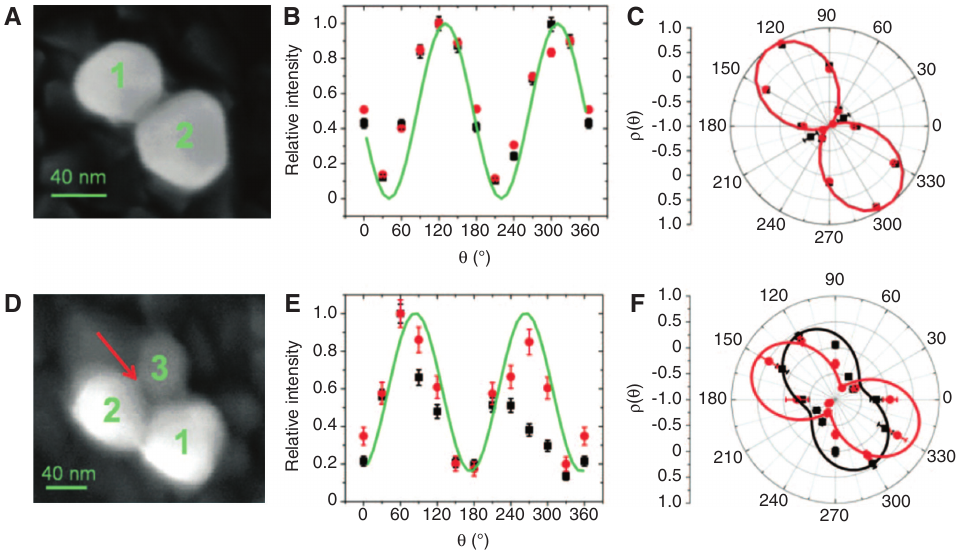
Figure 5: Polarization responses of NP dimer and trimer [53]. (A) A SEM image shows a dimer of Ag NPs, which is tilted about 40 ° from the vertical direction. (B) Normalized Raman scattering intensity at 555 nm (black squares) and 583 nm (red circles) as a function of the rotation angle of the incident polarization. The green line is the result of generalized Mie theory calculation of the normalized local field enhance- ment factor at 532 nm excitation. (C) Depolarization ratio measured at 555 nm (black squares) and 583 nm (red circles). Black and red lines show the results of Mie theory calculations performed at 555 and 583 nm, respectively. (D–F) Corresponding data for a NP trimer. The red arrow in (D) indicates the position of the molecule that leads to the best agreement between experiment and calculation. Reproduced with permission from Ref. [53]. Copyright 2008 National Academy of Sciences,